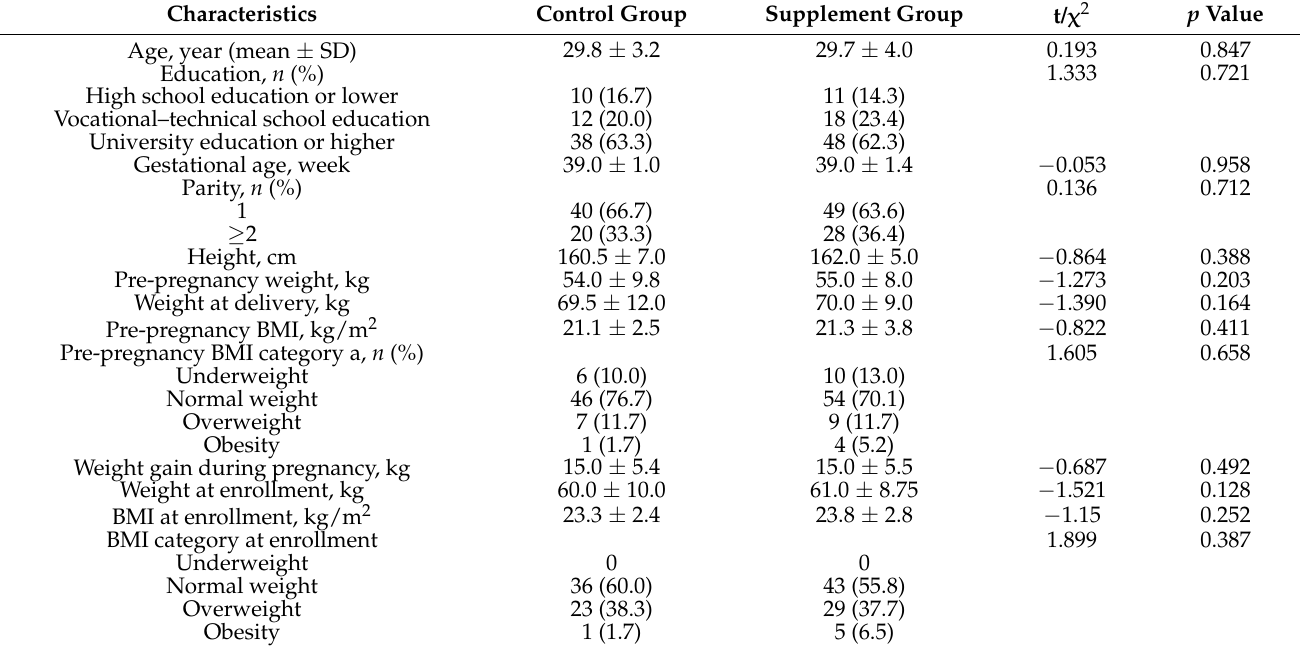
Table 1. Demographic characteristics of the lactating women in this